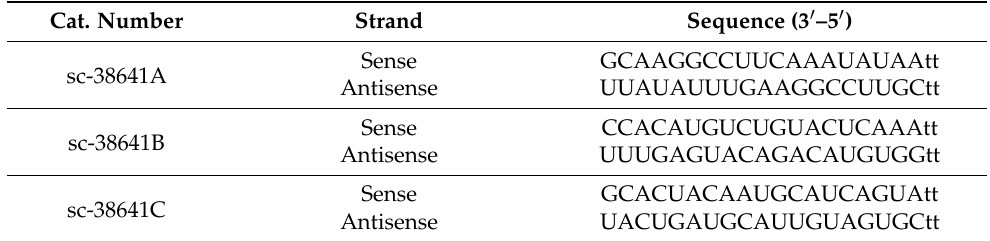
Table 1. Three different ZEB2 siRNA (sc-38641) sequences. Cat. Number